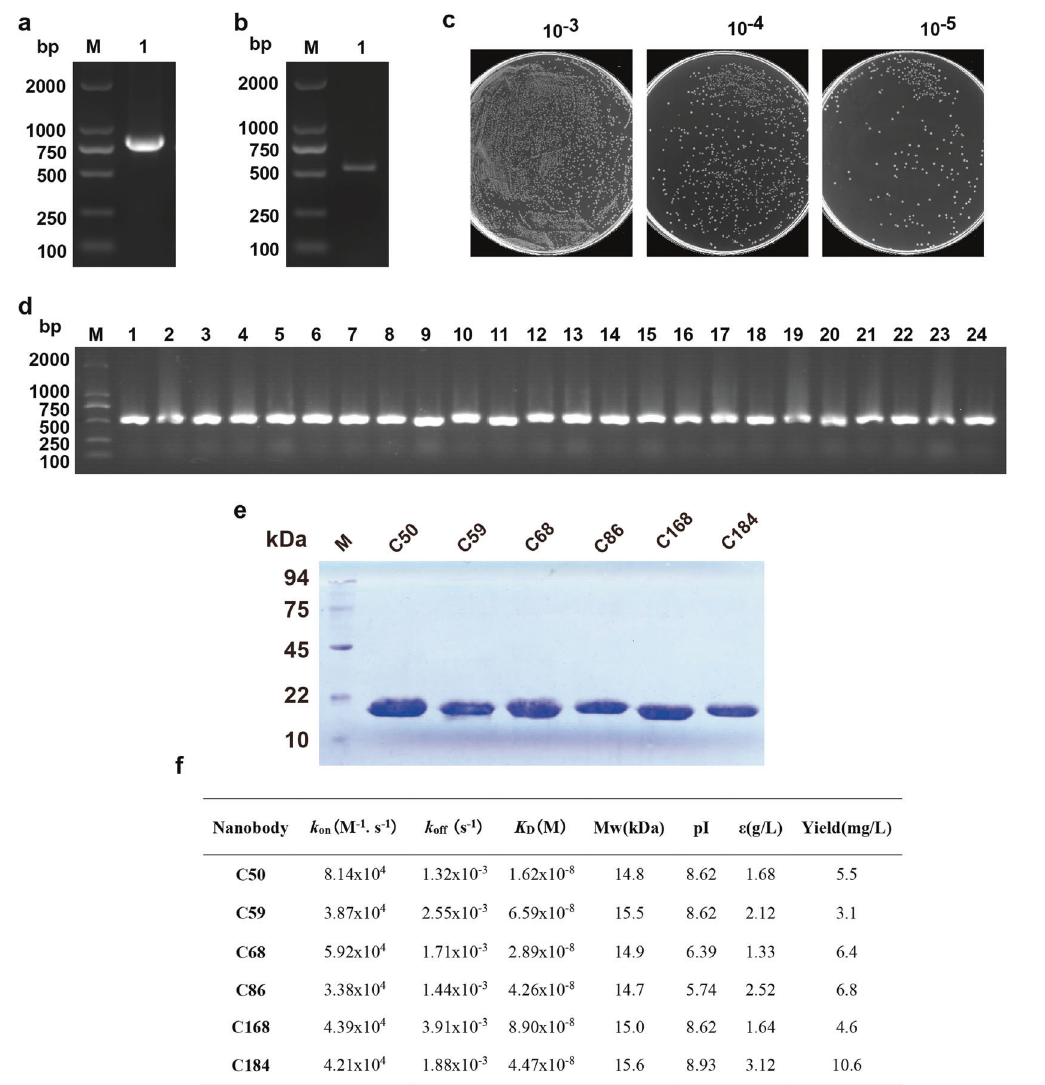
Fig. 1 Library construction, expression, and puri fi cation of CD105 nanobody. a , b The VHH genes were obtained by two steps PCR. c The library size was measured by counting the colonies number after serial dilution. d Twenty-four colonies were randomly picked to estimate the correct insertion rate of VHH genes by PCR ampli fi cation. e SDS-PAGE analysis of puri fi ed CD105-speci fi c nanobodies. f Properties of CD105- speci fi c nanobodies. The af fi nity of these nanobodies was determined by Biacore. Theoretical isoelectric point (pI), molecular weight (Mw), and extinction coef fi cient ( ε ) were calculated by the ExPAsy ProtParam